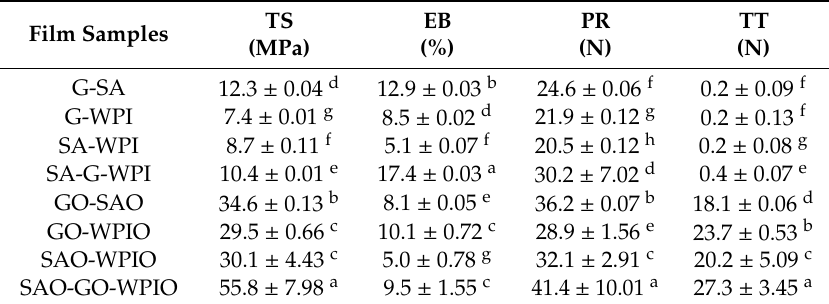
Table 2. Mechanical properties of laminated films a .